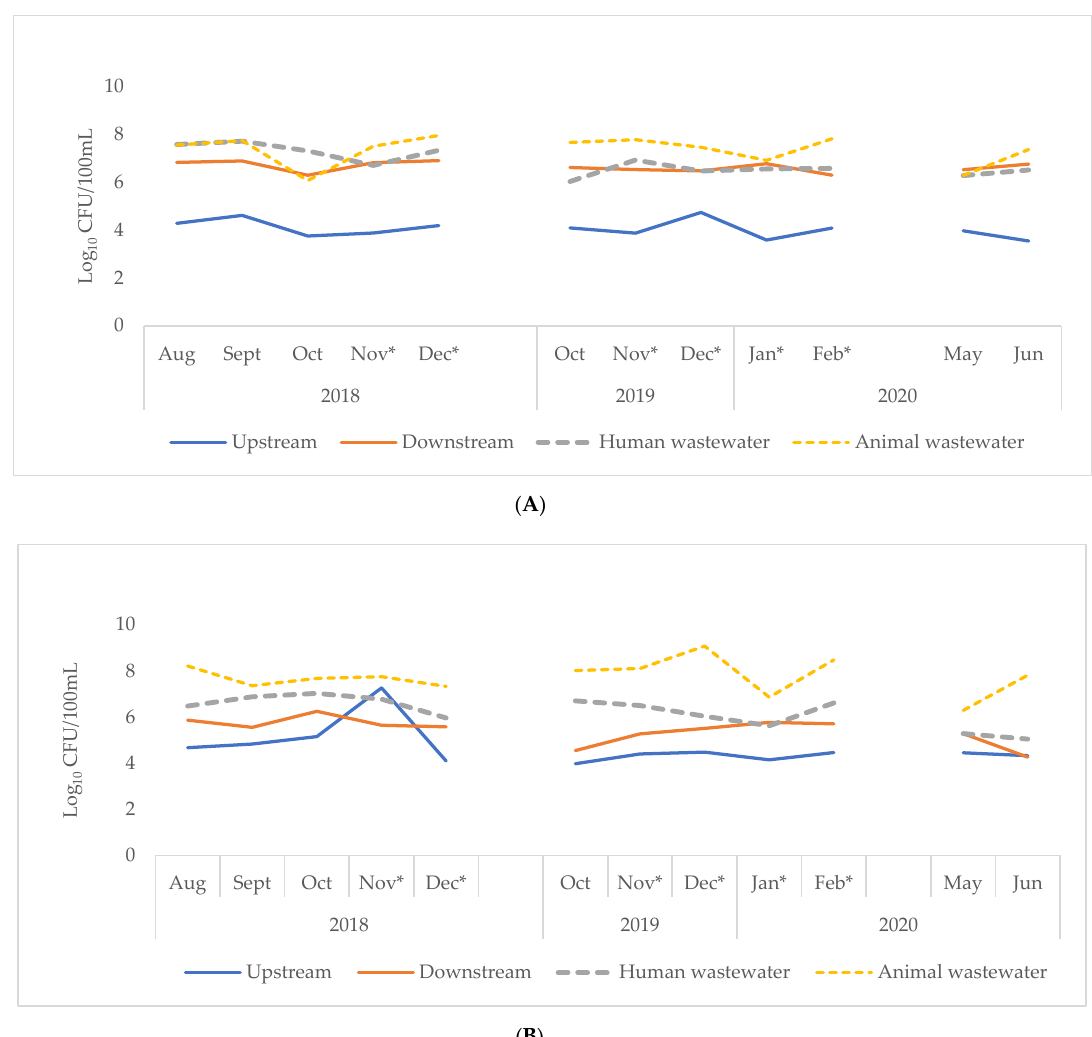
Figure 2. Comparison of concentrations of E. coli and ESBL-Ec among sampling sites in Accra ( A ) and Kasoa ( B ) for the periods of Aug. 2018 – Dec. 2019, Oct. 2019 – Feb. 2020, May, and Jun. 2020, Ec = E. coli , ESBL-Ec = Extended-Spectrum Beta- Lactamase E. coli , cfu = colony forming units.